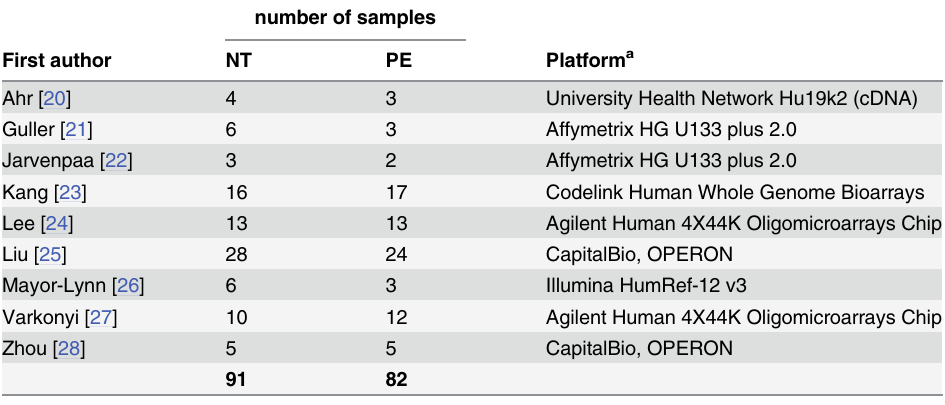
placentas from normotensive pregnancies. A detailed list of the 388 genes and the correspond- ing statistics is shown in S1 Table, corresponding forest plots are shown in S1 Fig. Comparison of the current 388-gene meta-signature with the gene list-driven signature of 40 genes we previously obtained from published gene lists reported as being differentially expressed in preeclamptic placenta [4] shows that most of the literature-based genes are also included in the 388-gene signature (S2 Table). In total, 12 genes from the gene list-driven Table 2. Studies excluded in the meta-analysis.